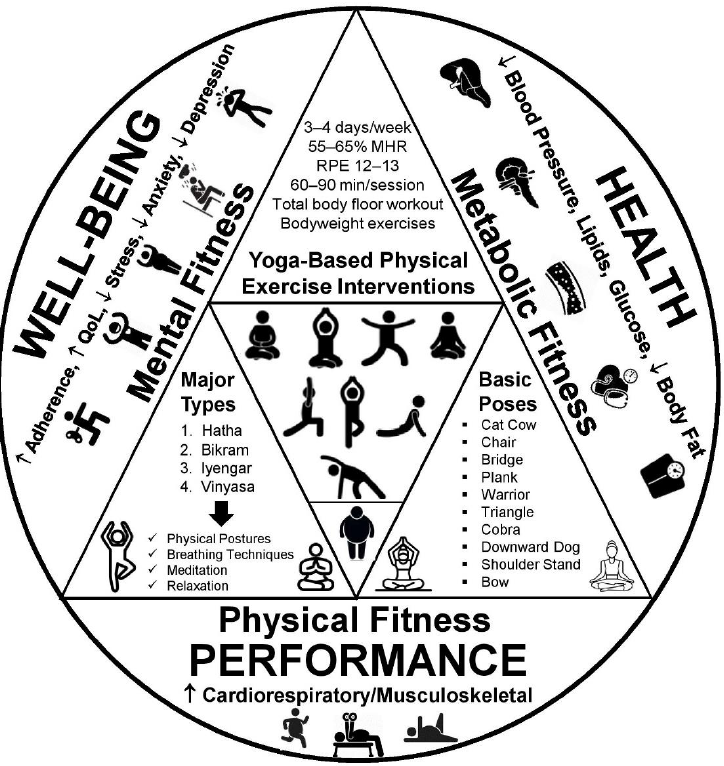
Figure 1. The psychophysiological effects of yoga interventions in overweight and obese individuals. MHR: maximum heart rate; RPE: rating of perceived exertion.